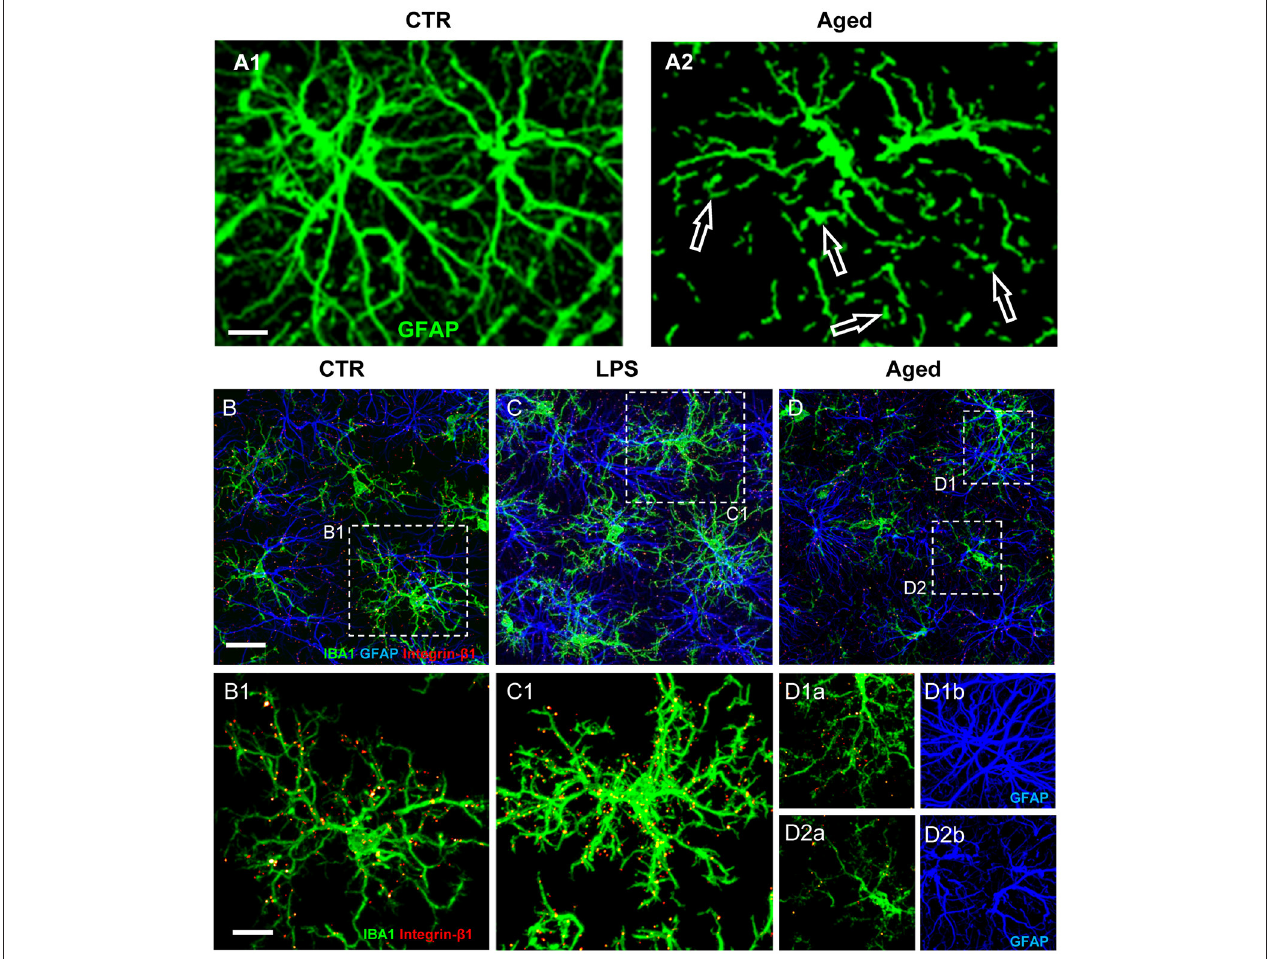
FIGURE 2 | (A) Z-projections of confocal stacks acquired in CA1 hippocampus showing GFAP (green) immunostaining in control (A1) and aged (A2) rats. (B–D) Confocal acquisitions of IBA1 (green), GFAP (blue), and integrin- β 1 (red) immunostaining in CA1 region of control (B) , LPS (C) , and aged (D) rats. (B1–D2b) Immunostaining of Integrin- β 1 in microglia of control, LPS-treated and aged rats [magnifications of framed regions in (B–D) ]; in (B1,C1,D1b,D2b) integrin- β 1 colocalization on microglial cells is highlighted omitting GFAP immunostaining. Scale bars: (A1,A2) : 7.5 µ m; (B–D) : 20 µ m; (B1–D2b) : 7.5 µ m [Modified from Lana et al.,